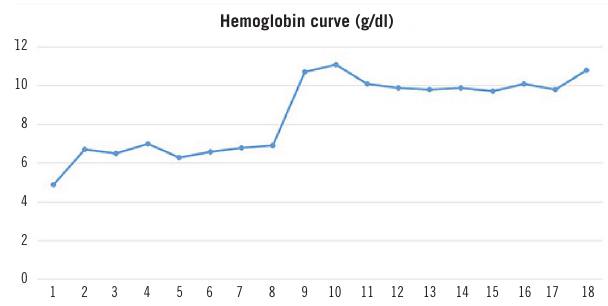
figurE 3 − Variation of hemoglobin concentration (g/dl) during hospital stay (g/dl)